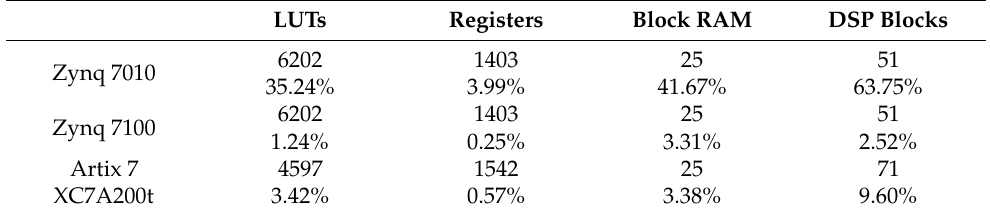
Table 1. Resource utilisation of a single flickermeter